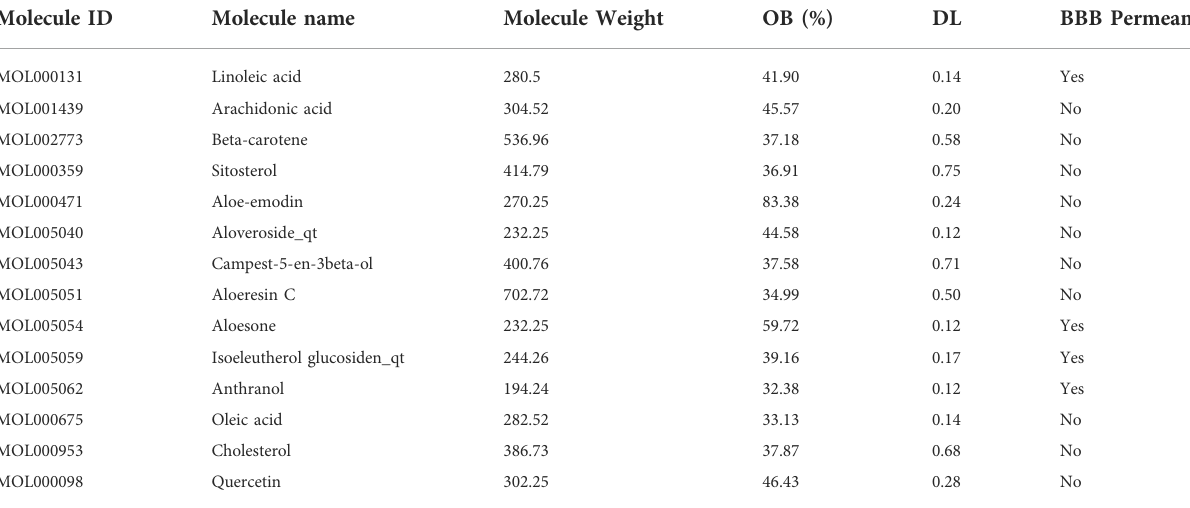
TABLE 1 The 14 active ingredients of Aloe vera